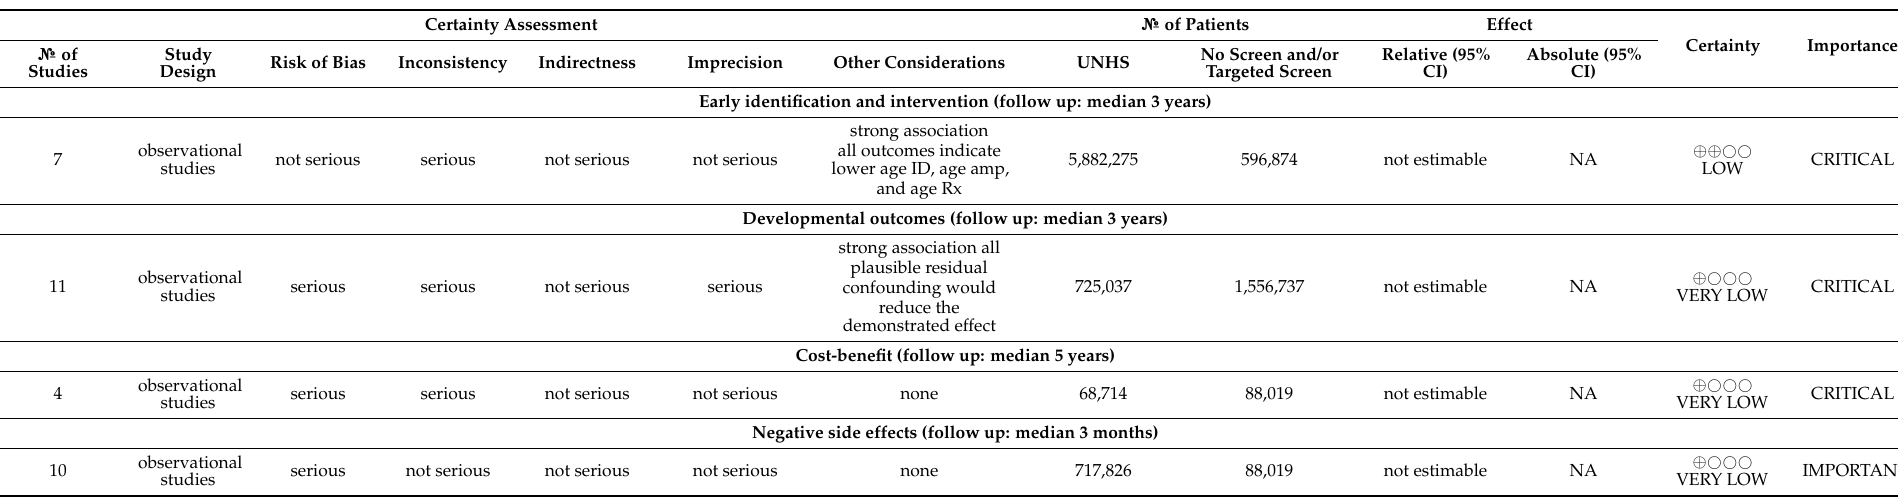
Table 5. GRADE level of evidence for UNHS